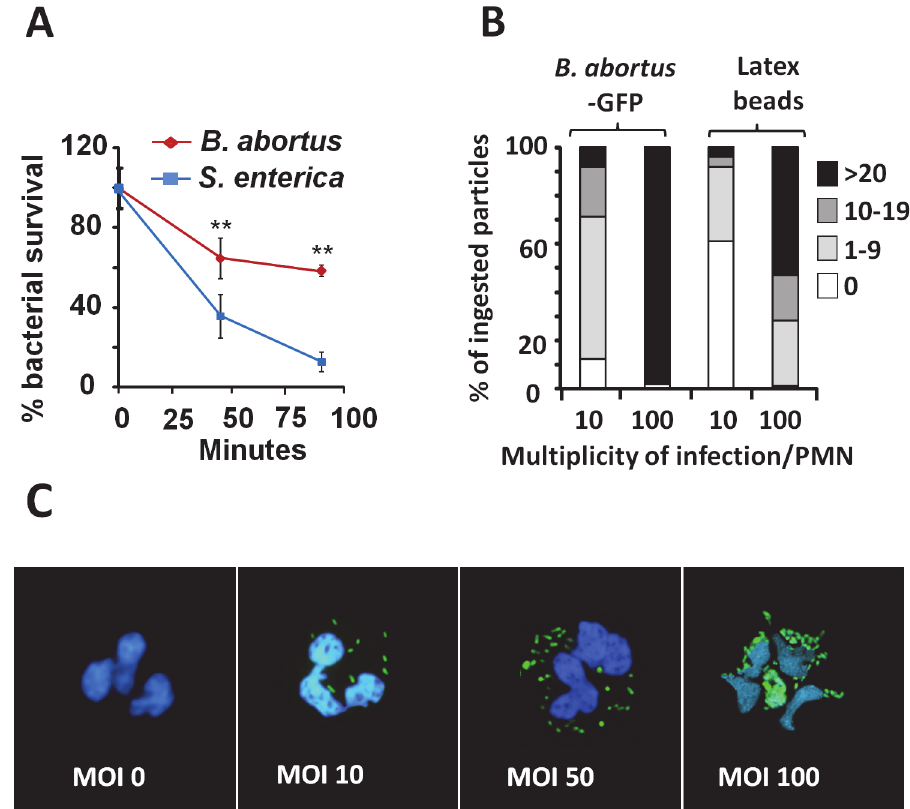
Fig 1. B . abortus is partially resistant to the killing action of PMNs. (A) PMNs were isolated from blood and incubated with B . abortus or S . enterica (MOI 5) and CFUs determined at different time points. (B) Heparinized blood was incubated with B . abortus -GFP or fluorescent latex beads for two hours (MOI 10 or 100). Blood smears were then fixed and mounted with ProLong Gold Antifade Reagent with DAPI. At least 100 PMNs were counted per sample and the number of intracellular bacterial or latex particles determined in each PMN and the proportion expressed as % of phagocytized particles. (C) Human PMNs infected with different MOI of B . abortus -GFP and stained as in “ B ” . Microscope images are at 400 × magnification. Representative PMNs with DAPI-stained nuclei and intracellular green fluorescent B . abortus were photographed under the microscope using the appropriate color filter channel. Images were cut from microscope field, contrasted and saturated using Hue tool to obtain suitable color separation. Images were then merged using Adobe Photoshop 8 software. Experiments were repeated at least three times. Values of p < 0.01 ( ** ) are